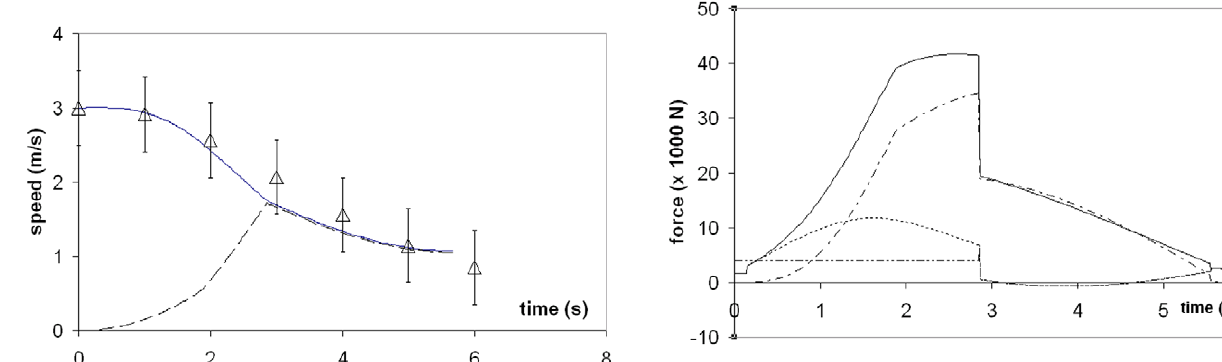
Figure 4. Theory meets experiment. Simulated speed of a 20.2 m fin whale (continuous line), as compared with data from digital tags [35] (triangles). The dashed line corresponds to the simulated speed of the engulfed mass. Note the equivelocity constraint operating during mouth closure (i.e., at t . 2.85 s).